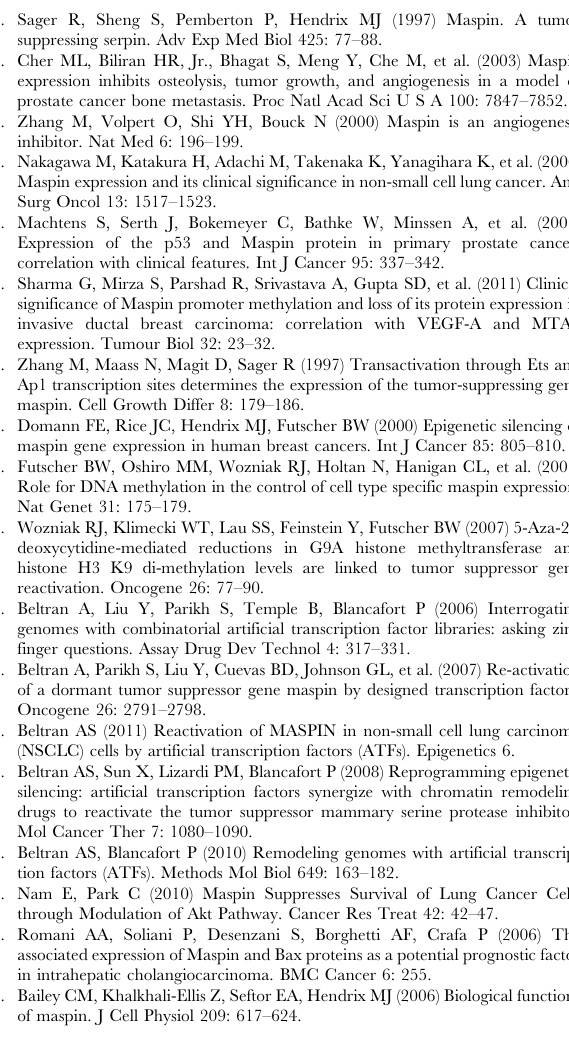
green. Figure S4 Gene clustering showing the 444 genes from the ATF-126-550 gene signature present in the NKI-295 patient dataset. Two-way hierarchy cluster stratified the 295 patients into 2 groups (cluster I and cluster II); patients in cluster II had a significant better relapse free survival outcome and overall survival outcome (in 18 years follow-up) than patients in cluster I. Each colored square on the upper right represents the relative mean transcript abundance (in log2 space) with highest expression being red, average expression being black, and lowest expression being green. Table S1 Genes up-regulated in ATF-126 + DOX versus 2 DOX.